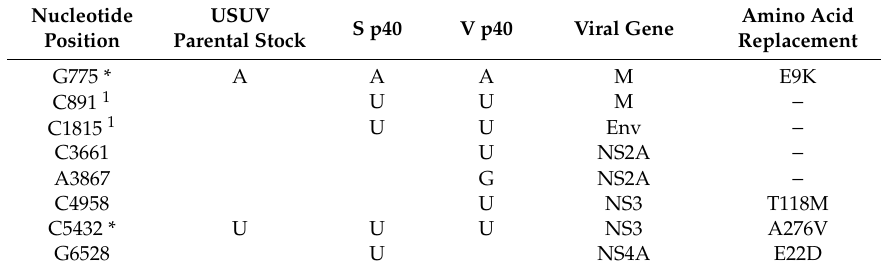
Table 1. Genomic di ff erences between parental stock (wild type) and persistent USUV (isolated from V p40 and S p40), and compared to the USUV reference strain (GenBank ID: